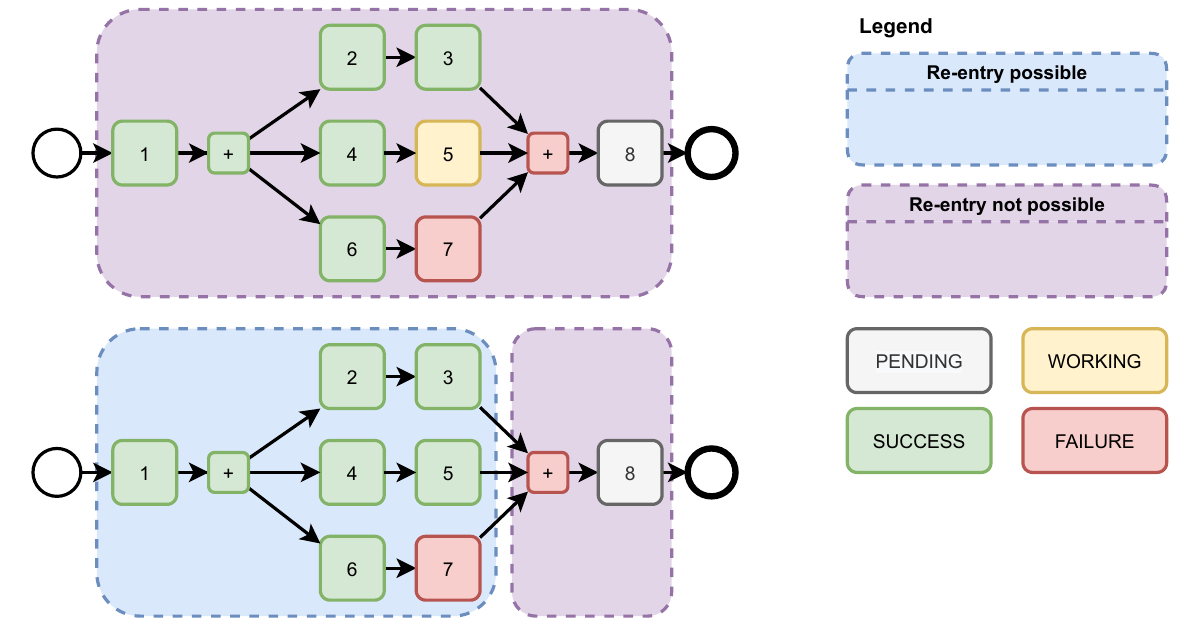
Figure 6. Toolchain restart states and possible re-entry